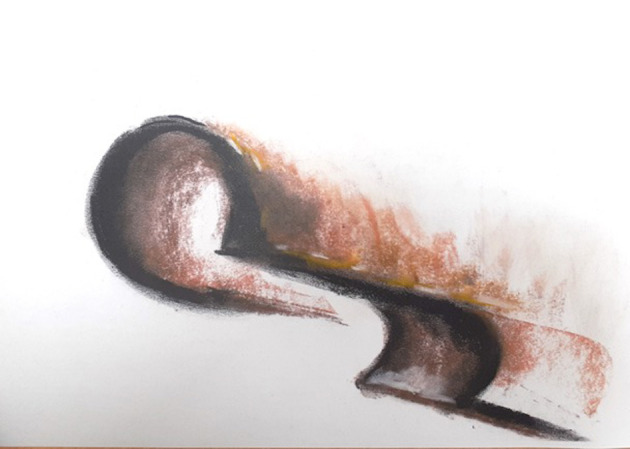
“Therapist's Image.”